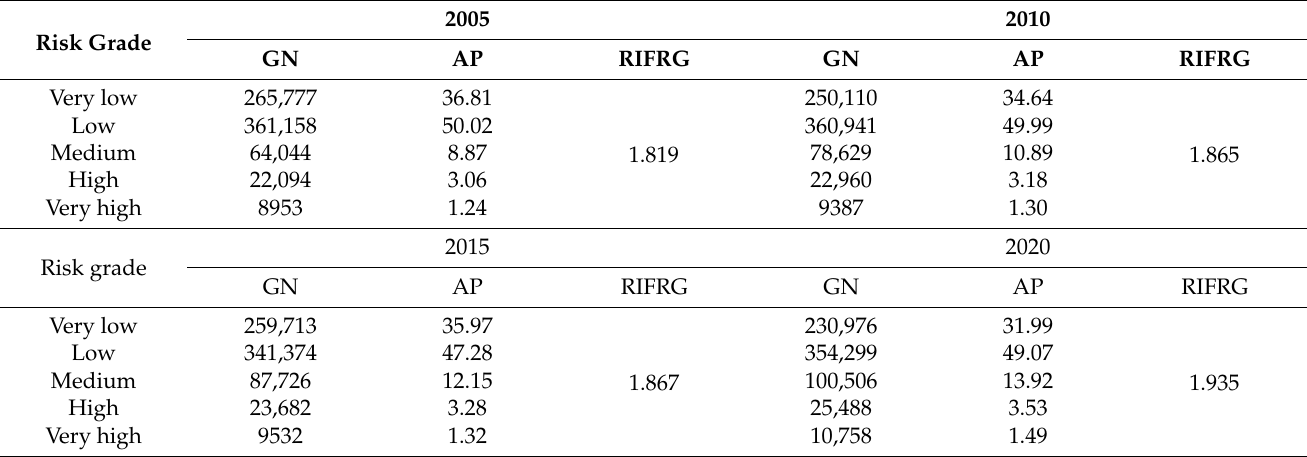
Table 6. Statistics of global flood risk grades for 2005, 2010, 2015, and